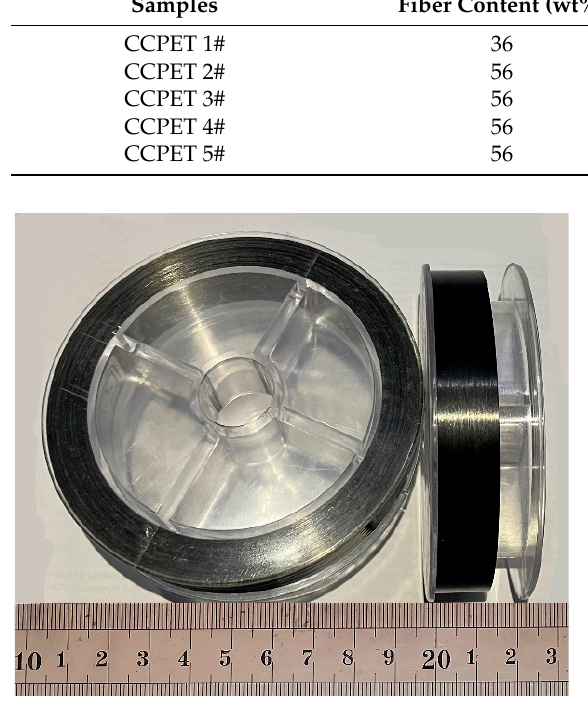
Figure 3. Prepreg tapes of CNT/CCF/PET.